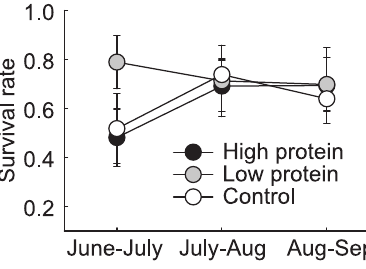
Figure 2. Treatment-wise population survival rate (mean ± se).